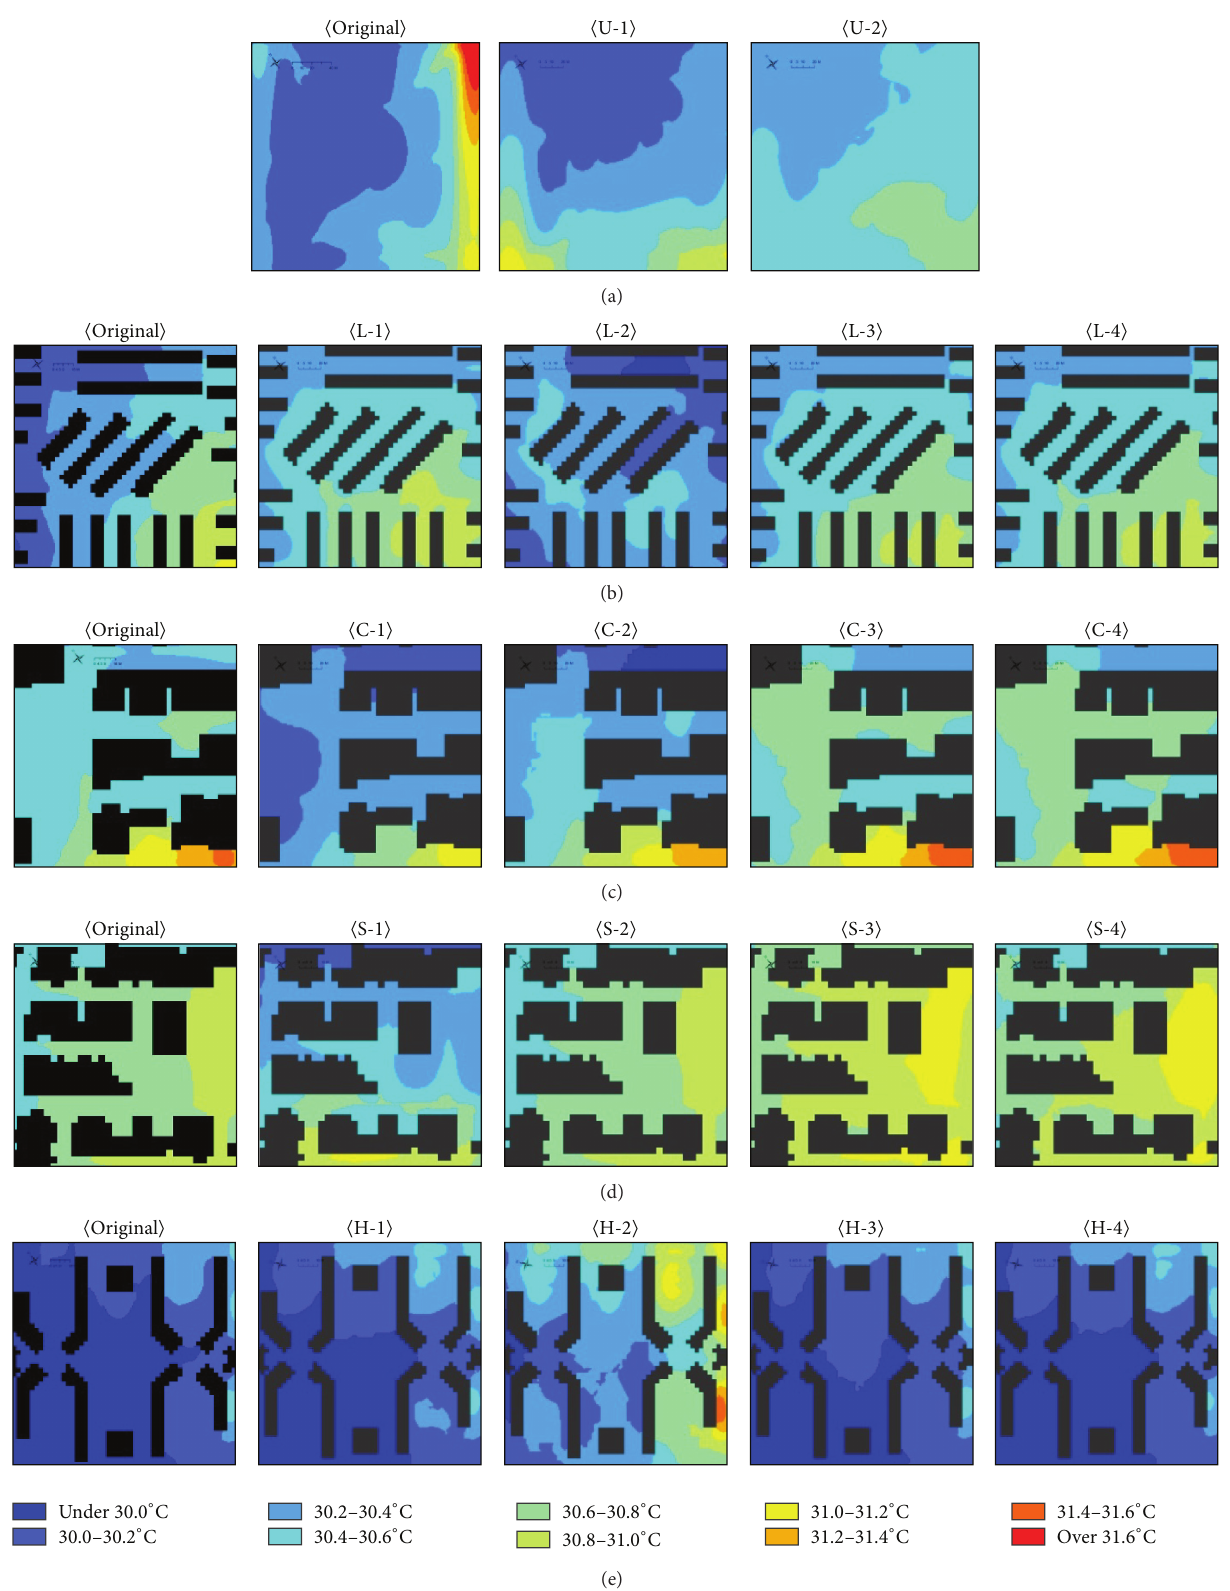
Figure 6: Changes in temperature distribution according to the scenario settings: (a) urban park area, (b) low-rise apartment area, (c) high- rise commercial area, (d) single residential area, (e) high-rise apartment